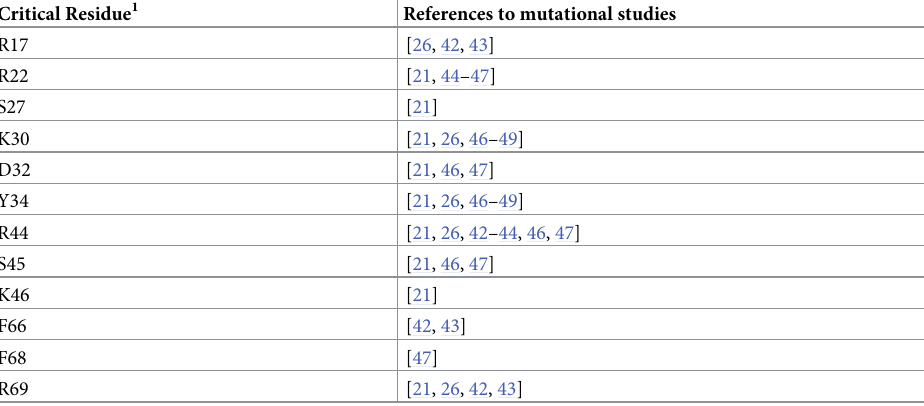
Table 1. Amino acid residues involved in 5mC binding found within the methyl-CpG-binding domain (PF01429) of MBD proteins. Critical Residue